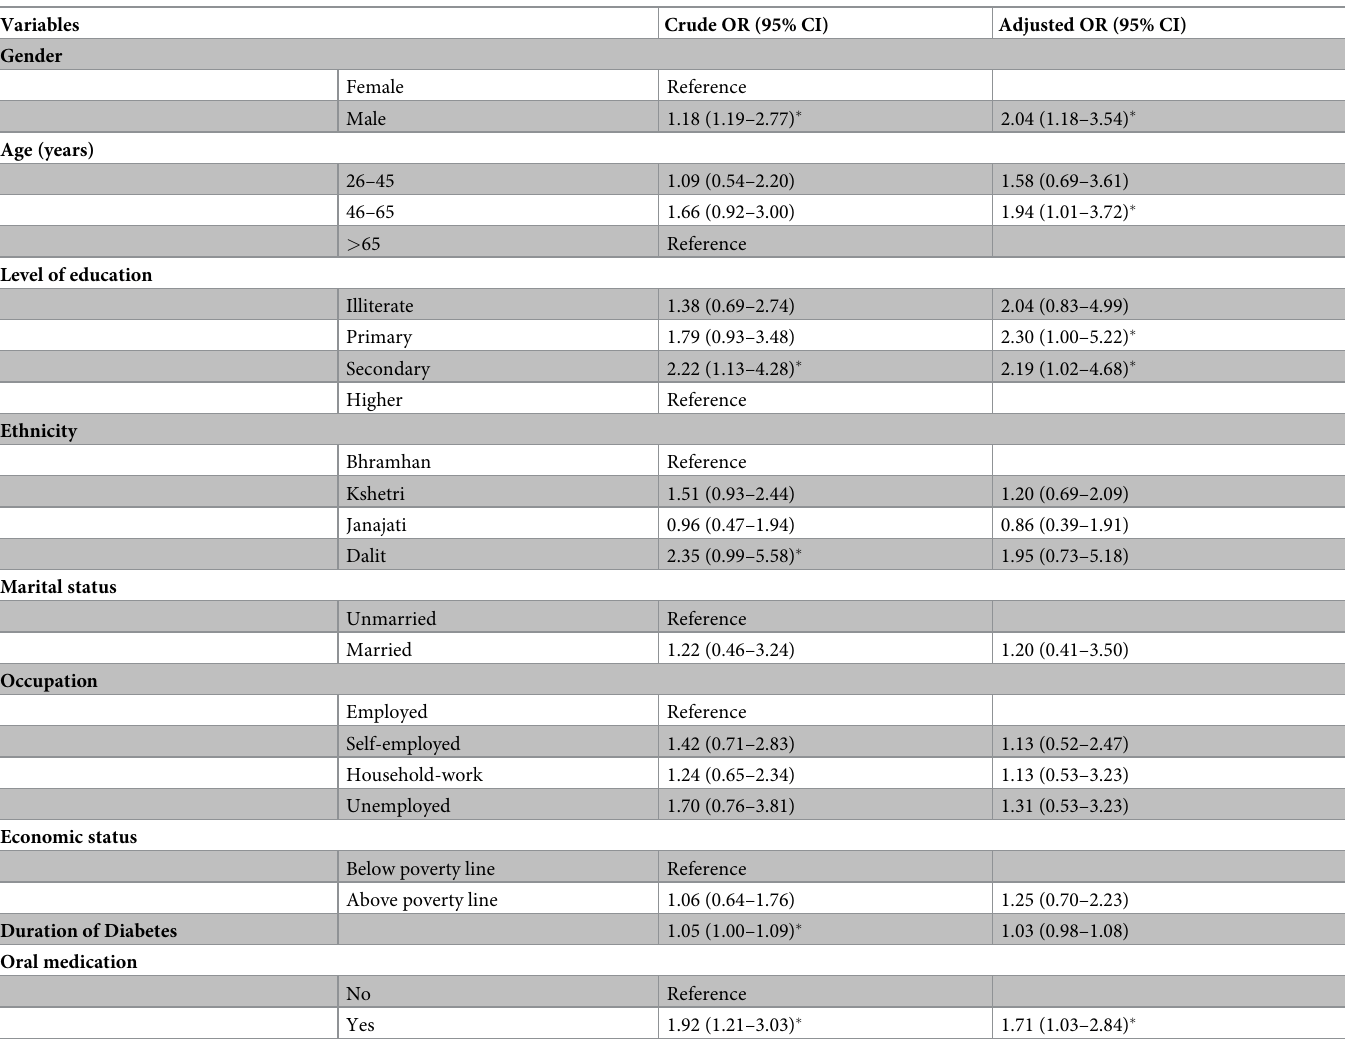
Table 5. Socio-demographic and clinical factors associated with clustering four or more cardiovascular disease risk factors among study